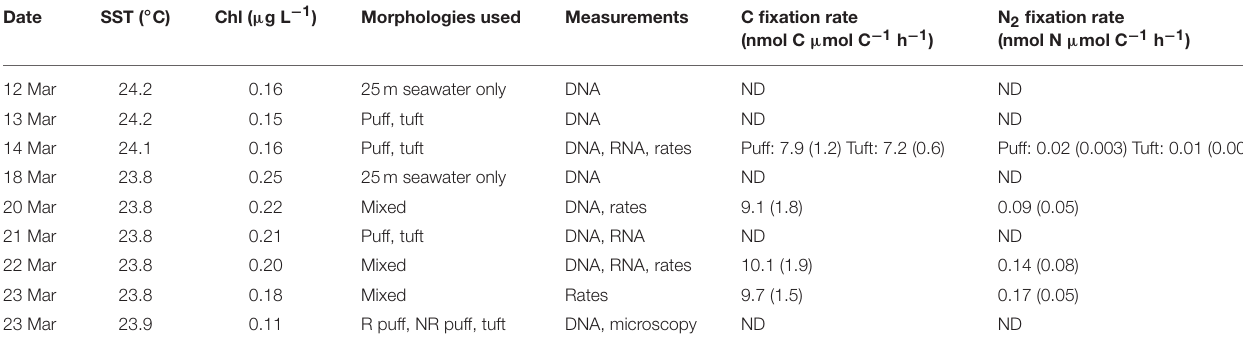
TABLE 1 | Summary and environmental conditions for sampling dates during a March 2014 cruise at Stn. ALOHA. Date Morphologies used